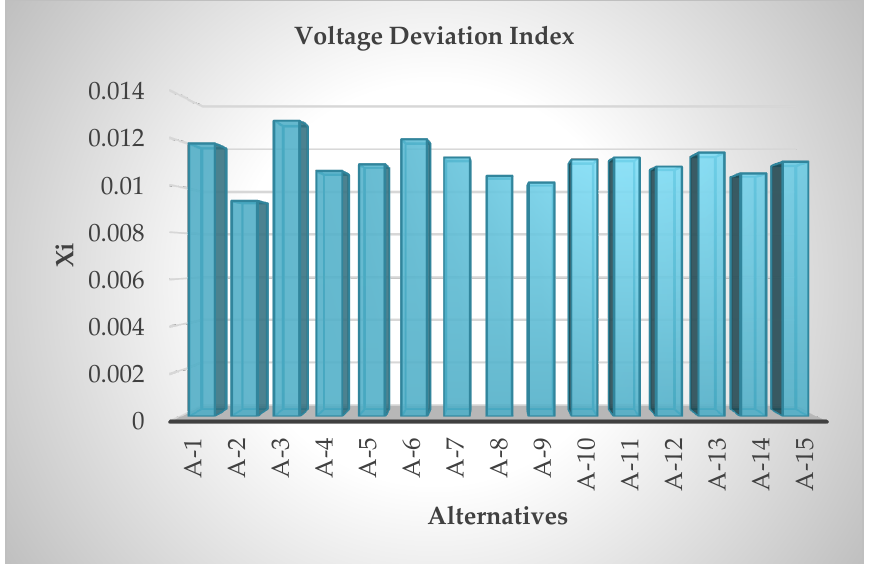
Figure 8. Voltage deviation index of each alternative.